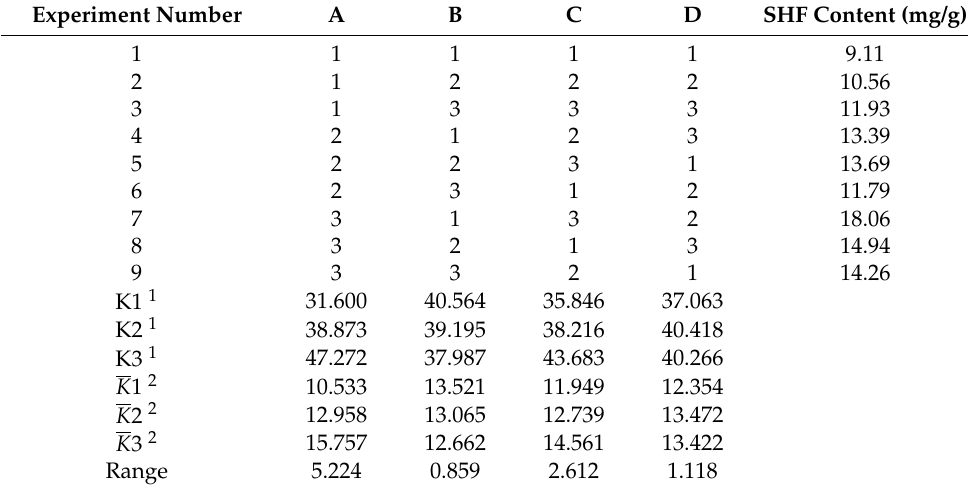
Table 3. Orthogonal test